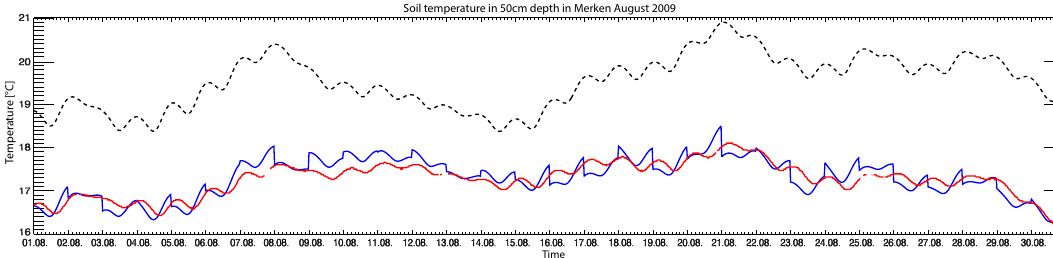
Figure 6. Soil temperature in Merken in August 2009 at 50cm depth. Colours are as in Fig.